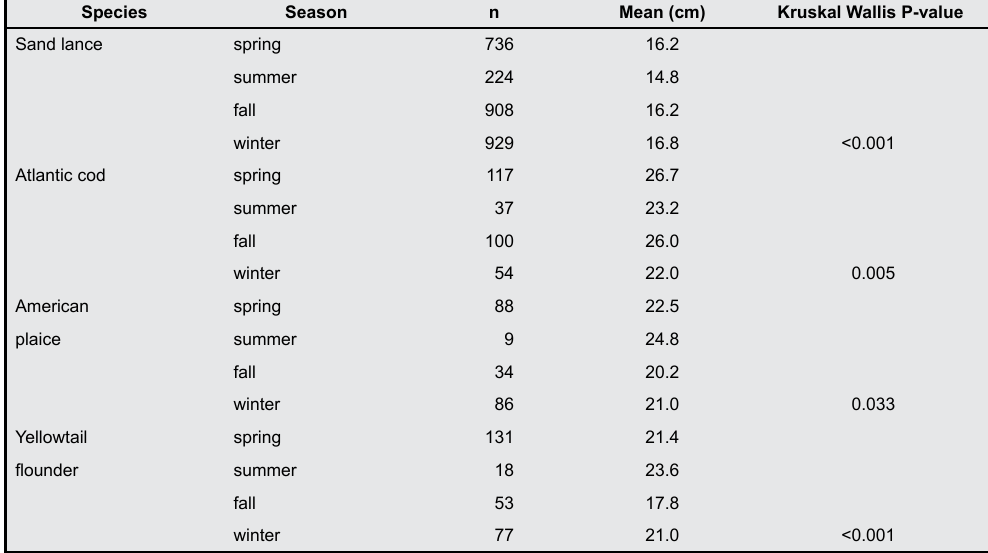
Table 4 . Seasonal variation in measured prey lengths for 4 species in the grey seal diet, all years combined. (Scientific names in Appendix.) Species Sand